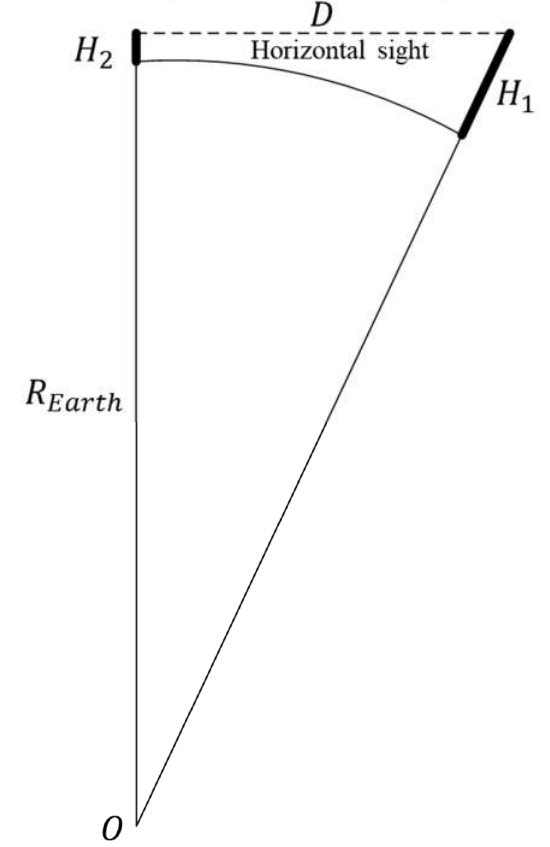
Figure 4 Schematic diagram of visual radius